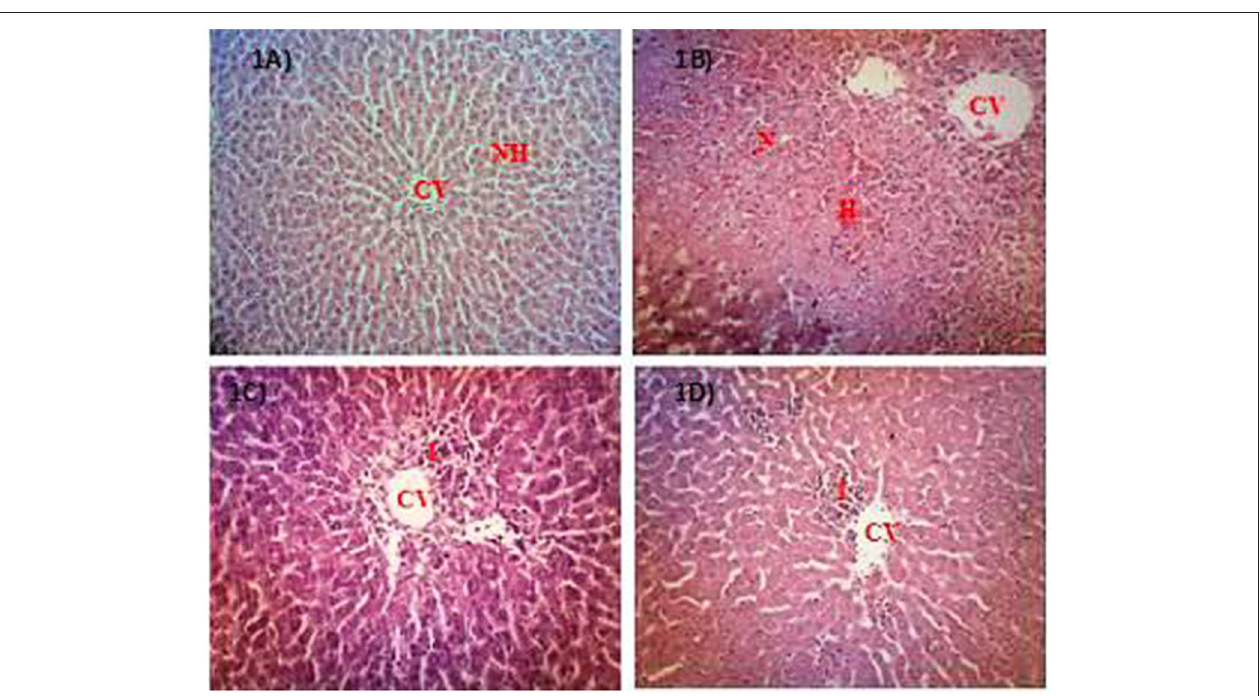
FIGURE 1 | Microscopic examination of PCM-intoxicated rat’s liver tissues pretreated orally with PEMC, EAMC or AQMC at the dose of 250 mg/kg. Photomicrographs show the liver tissue section of: (A) normal group (untreated), which showed normal liver architecture consisting of normal hepatocytes (NH) and central vein (CV); (B) hepatotoxic group (orally treated with only 3 g/kg PCM), which shows massive necrosis (N), hemorrhage (H) and inflammation (I); (C) positive group (orally pre-treated with 50 mg/kg NAC followed by PCM), which showed preservation of NH with mild I; (D) AQMC-pre-treated group followed by PCM, which showed normal liver architecture with mild I. PEMC and EAMC did not show hepatoprotective activity (data not shown). (100x magnification). NH, normal hepatocyte; CV, central vein; N, necrosis; I, inflammation; H, hemorrhage.